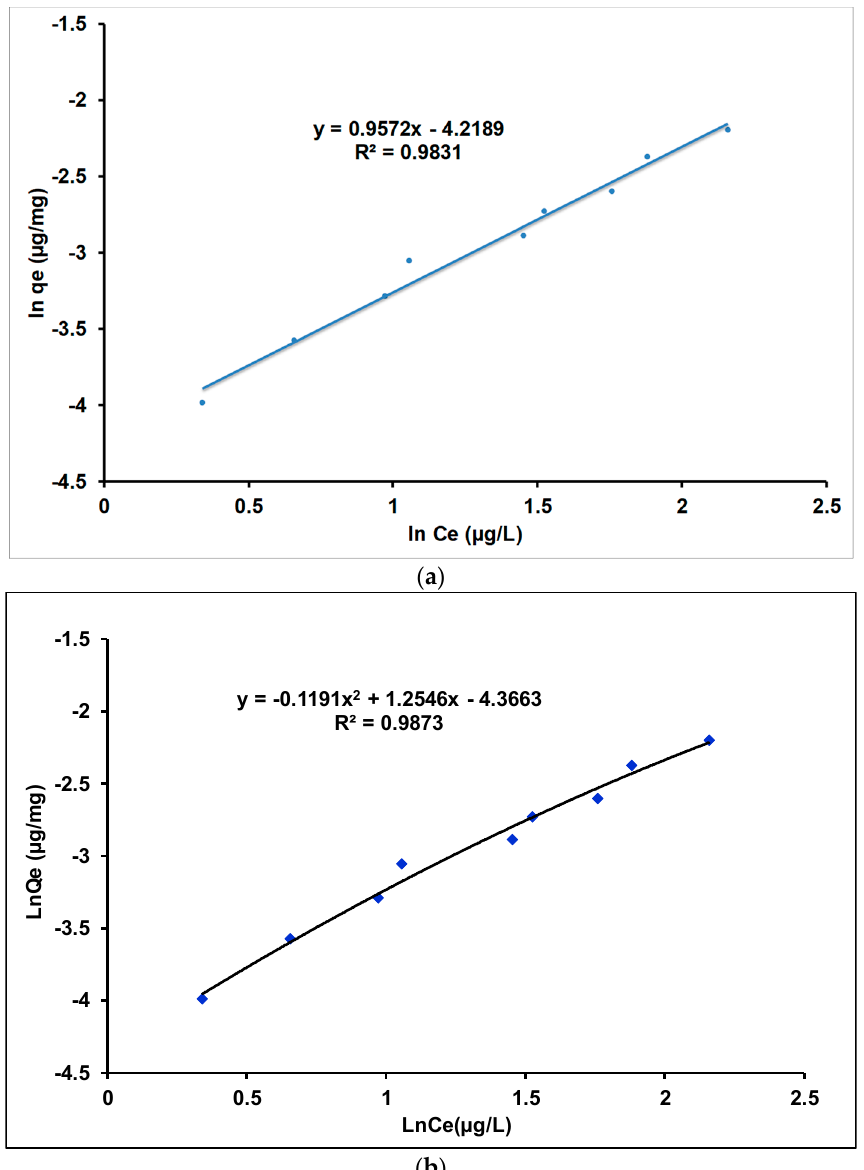
Figure 15. Freundlich isotherm of Tl(I) adsorption on γ ANPs: ( a ) linear model and ( b ) quadratic model. Table 4. Isotherm parameters of Tl(I) adsorption on γ ANPs.